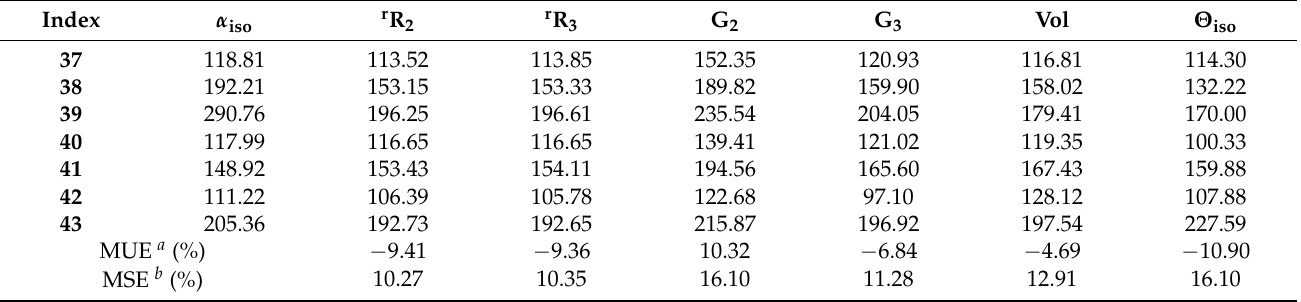
Table 6. Comparison of molecular polarizabilities ( α iso , in Bohr 3 /mol) at S 1 predicted with the linear regression equations in Table S2 with conventional data as a reference for all the systems in Scheme 3.